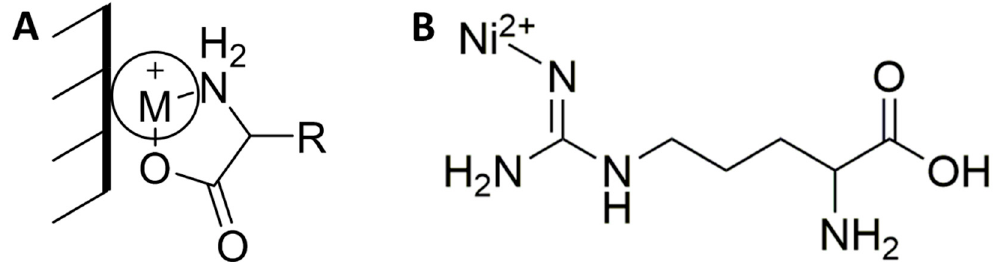
Figure 1. ( A ) Chelation intermediate of amino acid with metal nanoparticle and ( B ) arginine Ni(II) complex through the guanidine moiety.